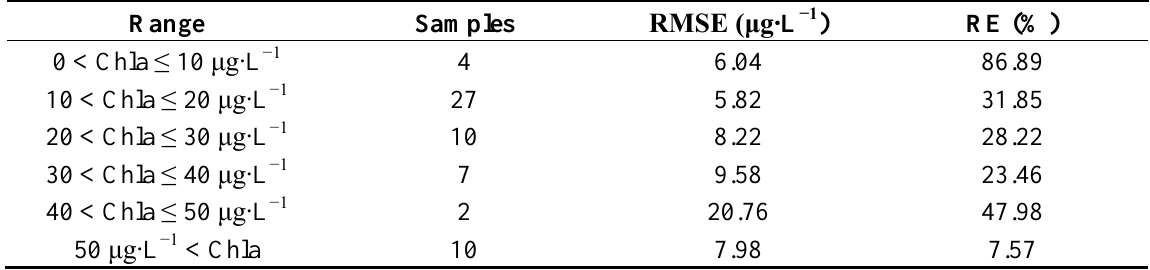
Table 3. Validation of the spectral decomposition model with in situ